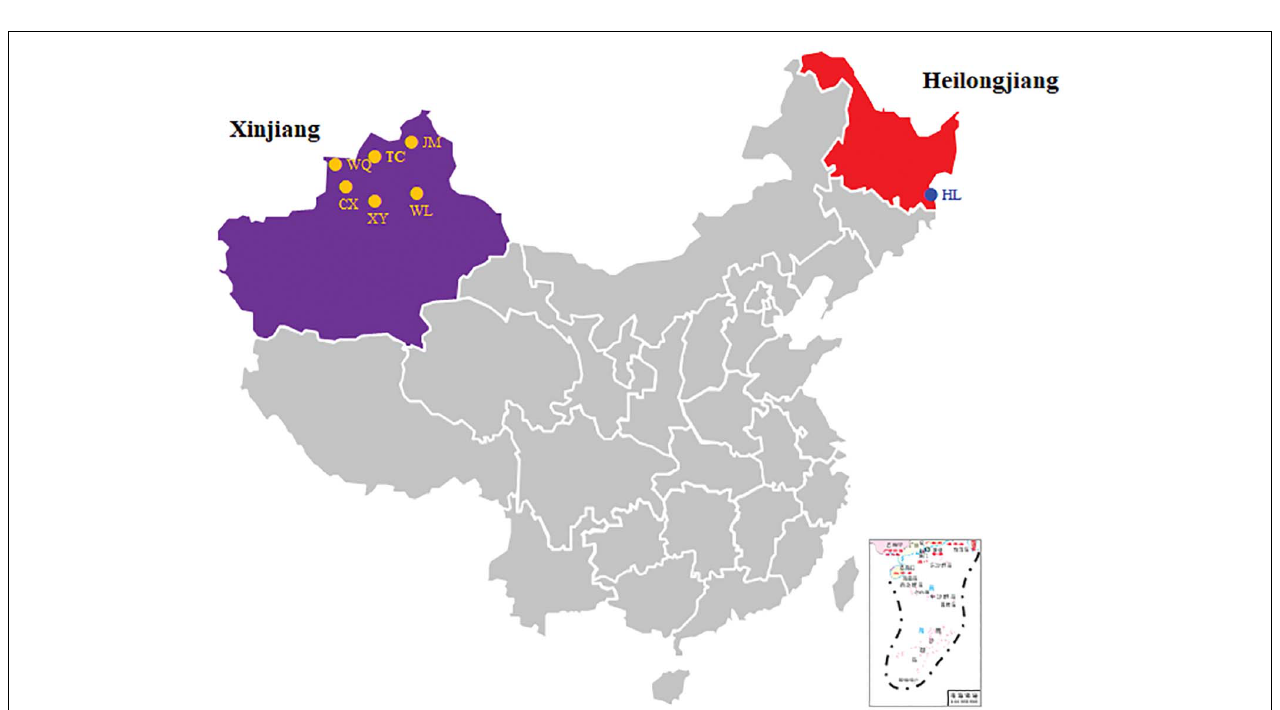
Frontiers in Microbiology |